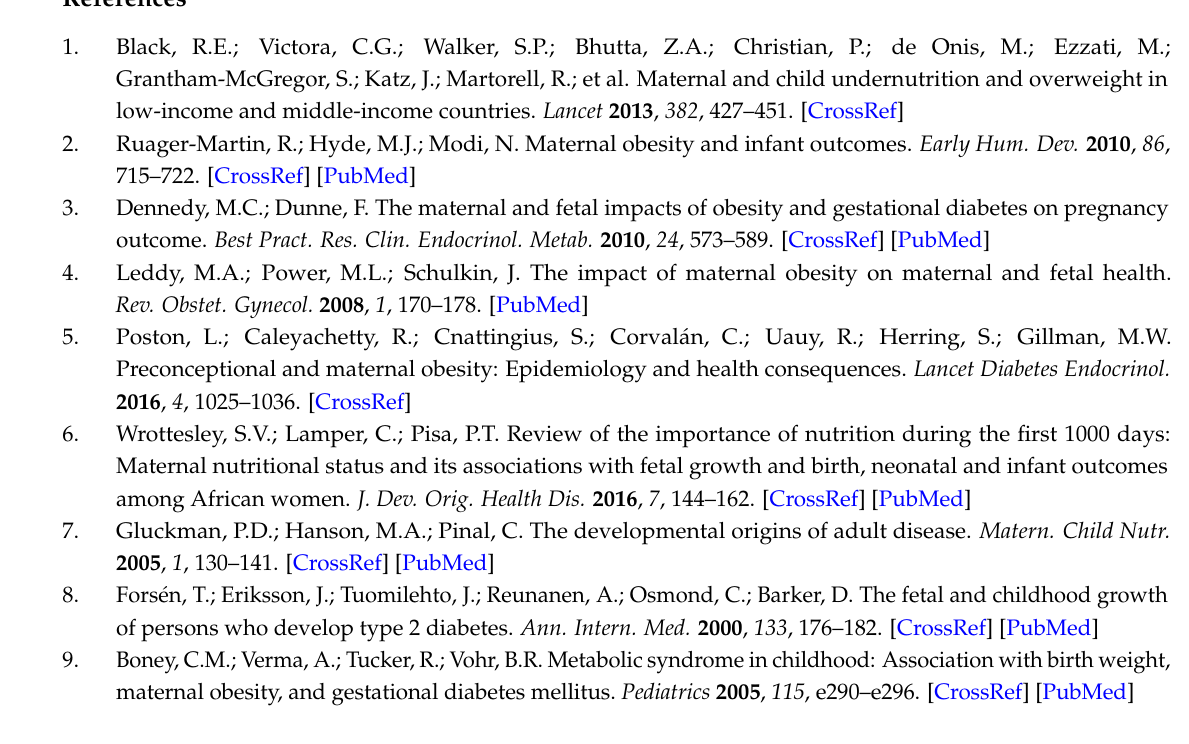
Figure S1: Scree plot of eigenvalues after principal component analysis; Table S1: Associations between maternal characteristics and dietary pattern scores ( n =